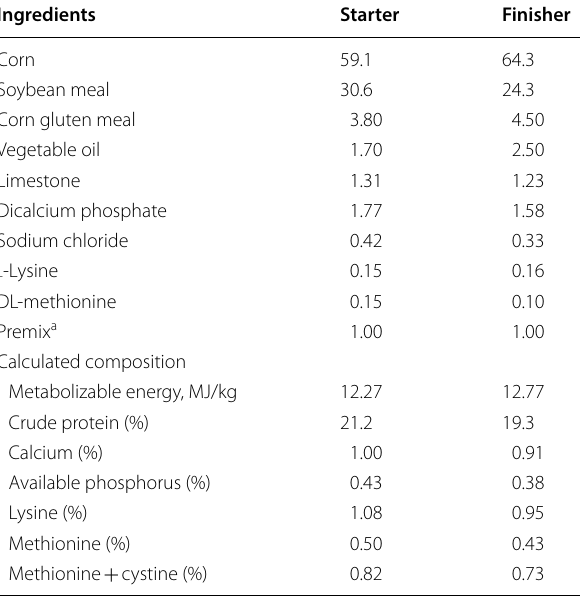
Table 1 Composition and nutrient levels of basal diet for broiler chickens (g/kg)